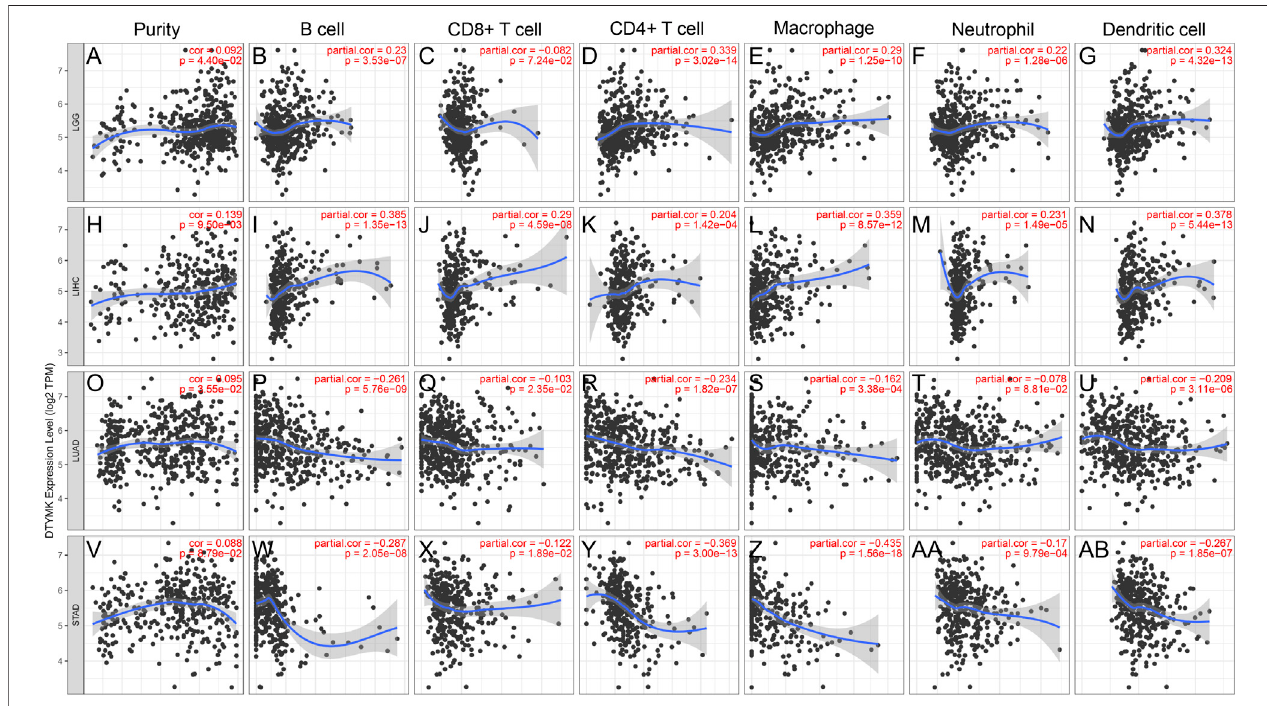
FIGURE 5 | DTYMK expression is correlated with immune in fi ltration in cancers as analyzed using the TIMER database. DTYMK expression positively correlated with tumor purity in LGG (A) , LIHC (H) , LUAD (O) and STAD (V). In LGG, DTYMK expression positively correlated with in fi ltration of B cell (B) , CD4 + T cell (D) , macrophage (E) , neutrophil (F) , and dendriticcell (G) ; InLIHC, DTYMK expressionpositively correlatedwithin fi ltrationofB cell (I) , CD8 + T cell (J) , CD4 + Tcell (K) , macrophage (L) , neutrophil (M) ,anddendriticcell (N) ;InLUAD,DTYMKexpressionnegativelycorrelatedwithin fi ltrationofBcell (P) ,CD8 + Tcell (Q) ,CD4 + Tcell (R) ,macrophage (S) ,neutrophil (T) , and dendritic cell (U) ; In STAD, DTYMK expression negatively correlated with in fi ltration ofB cell (W) , CD8 + T cell (X) , CD4 + T cell (Y) , macrophage (Z) , neutrophil (AA) , and dendritic cell (AB) . LGG, Brain lower grade glioma; LIHC, Liver hepatocellular carcinoma; LUAD, Lung adenocarcinoma; STAD, Stomach